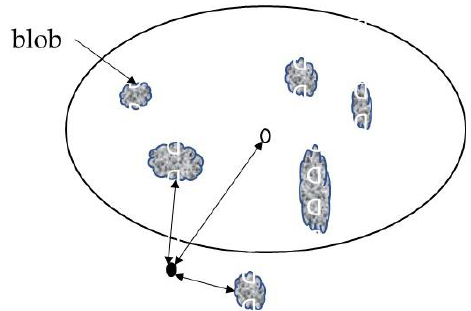
Figure 1. Elliptical distribution of true negative (TN) specimens under the classical assumption of multinormal distribution where nutrient centroids are represented by the empty circle. Data are distributed as ‘Islands’ or ‘ blobs ’. Some TN specimens are located in ‘ blobs ’ outside the ellipse. The diagnosed specimen (dark circle) is located at shorter distance from two blobs ’ centroids compared to the regional centroids.